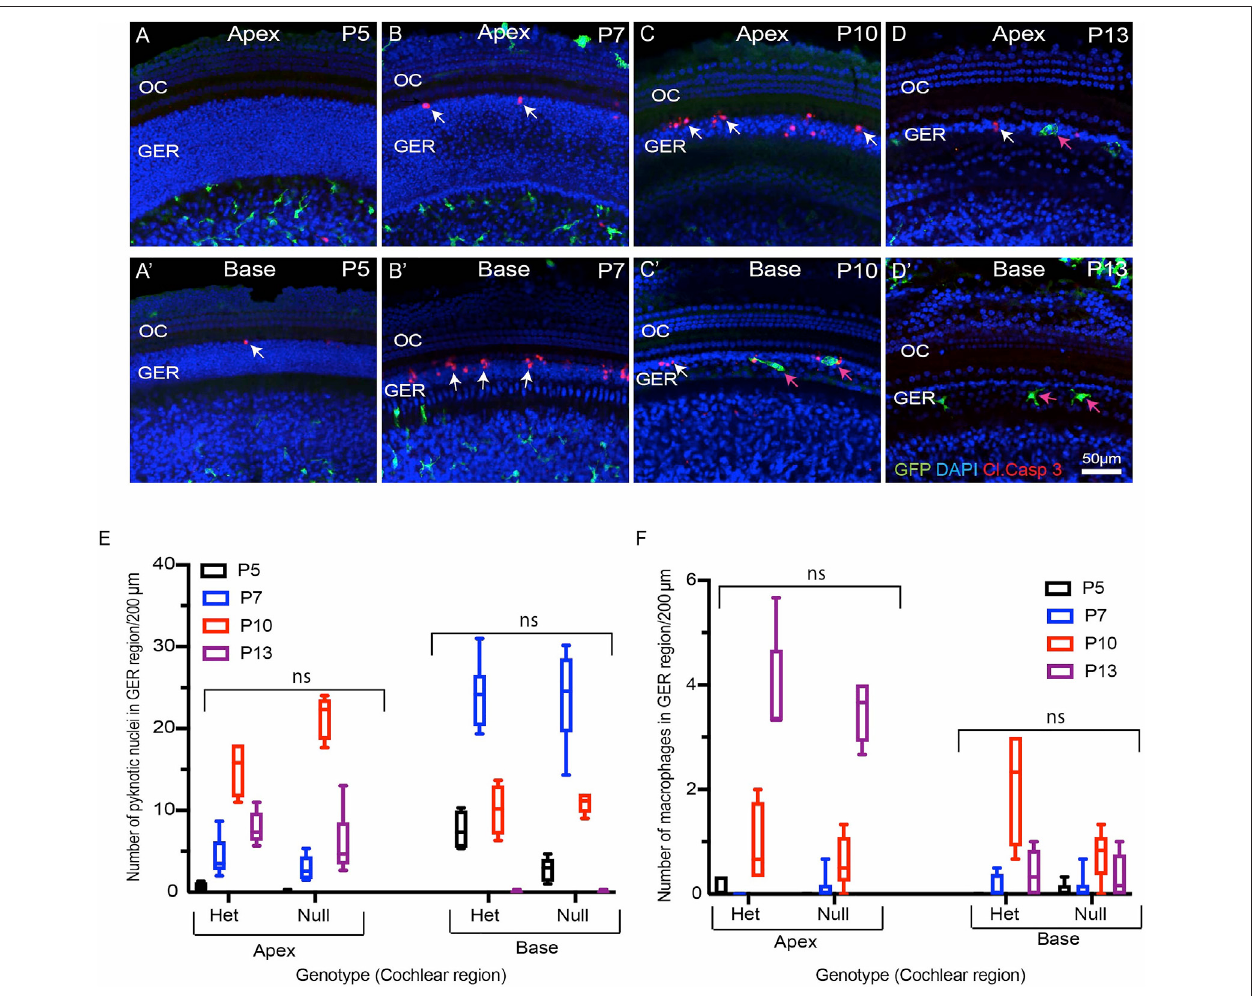
FIGURE3| ProgressionofdevelopmentalapoptosisandmacrophagerecruitmentisnotaffectedbygeneticdeletionofCX3CR1. (A – D 9 ) Sensoryepitheliumofthe developing cochlea of CX3CR1-null mice. The patterns of cell death (white arrows, cleaved caspase-3) and macrophage recruitment (magenta arrows, GFP) are